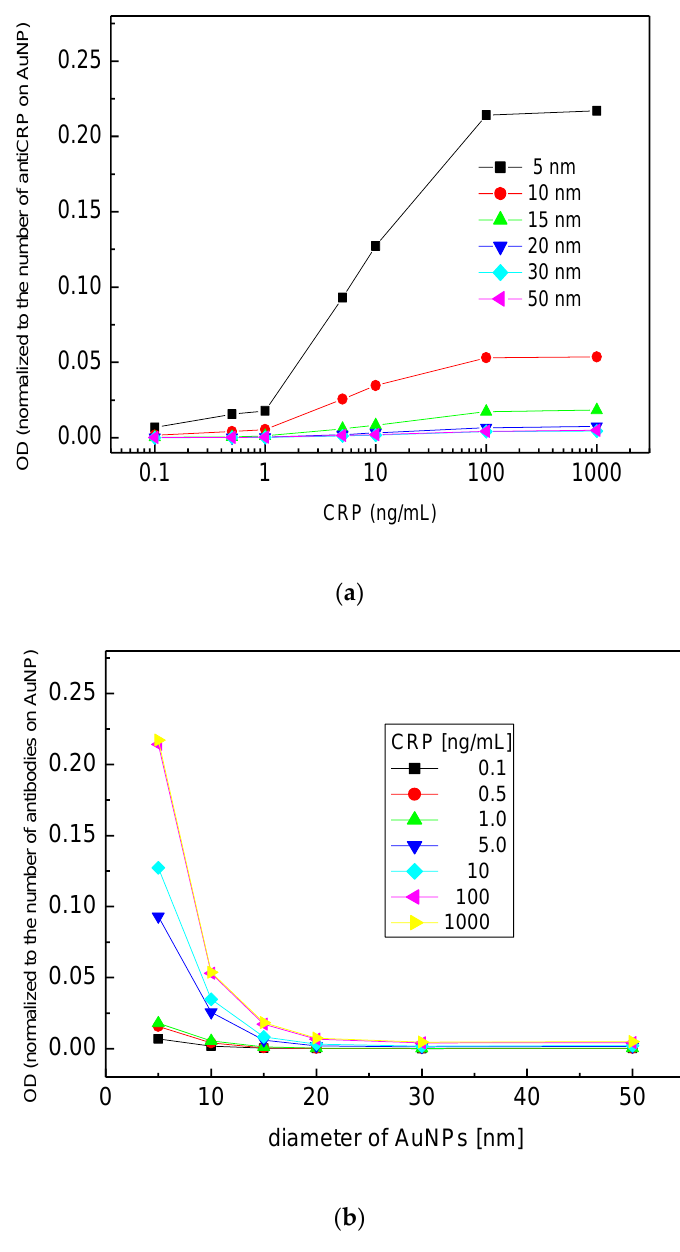
Figure 2. Normalized plots of Figure 1c based on encapsulating antibodies of each AuNP when optical densities were plotted against ( a ) CRP concentration, and ( b ) diameters of AuNPs.